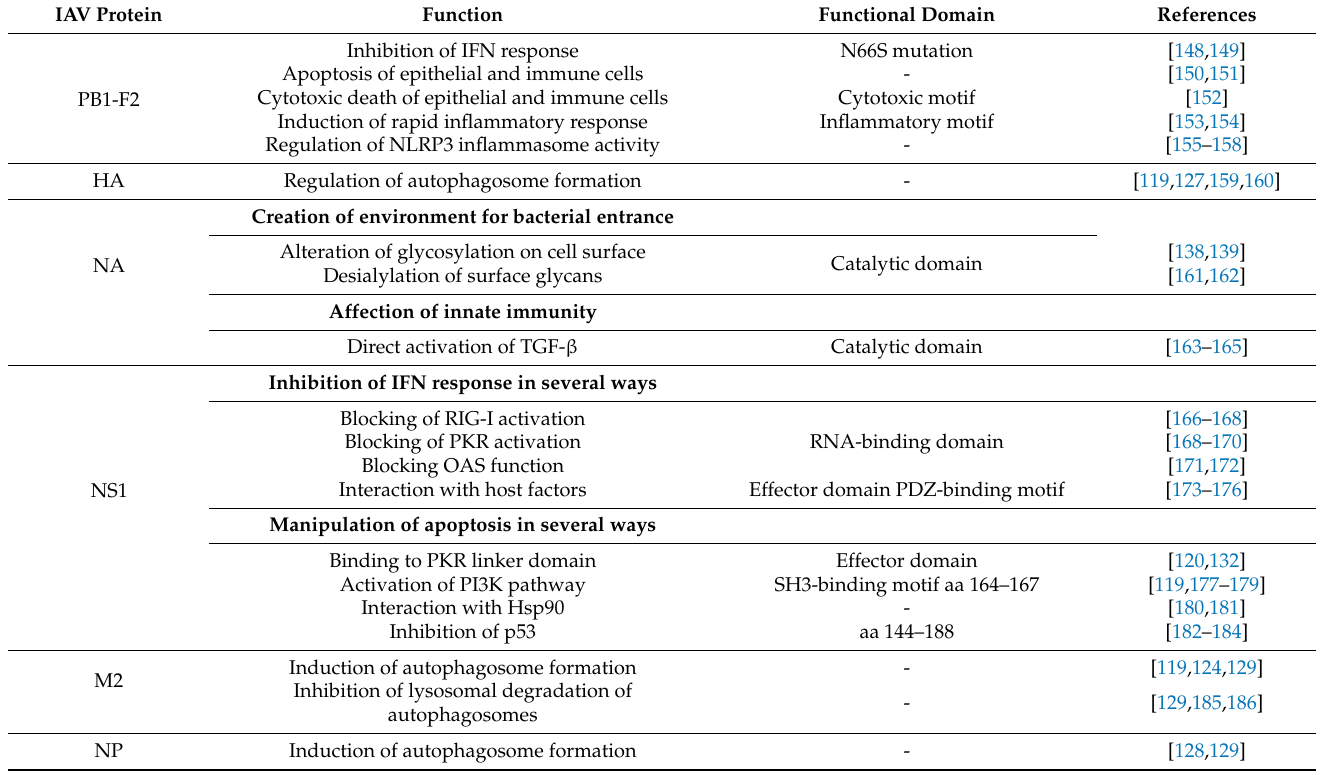
Table 1. Function of IAV proteins predisposing host to pneumococcal